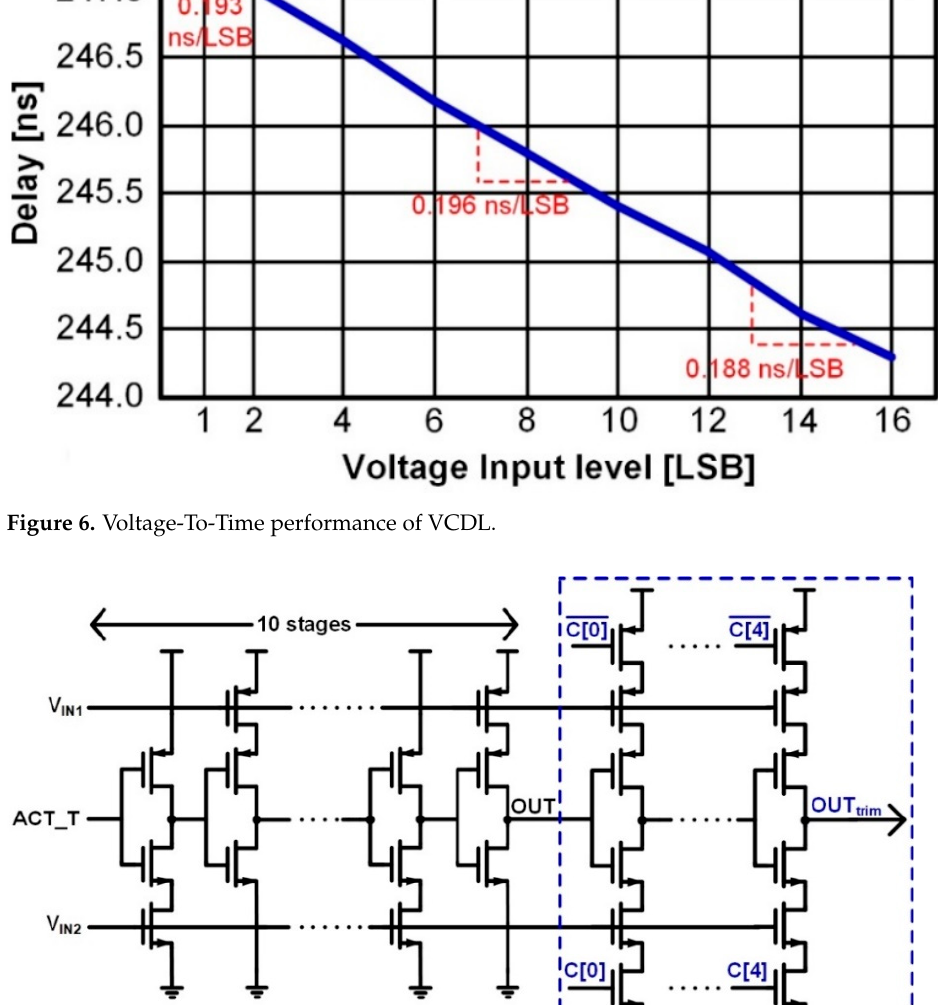
Figure 7. Time-domain comparator with trimming option.